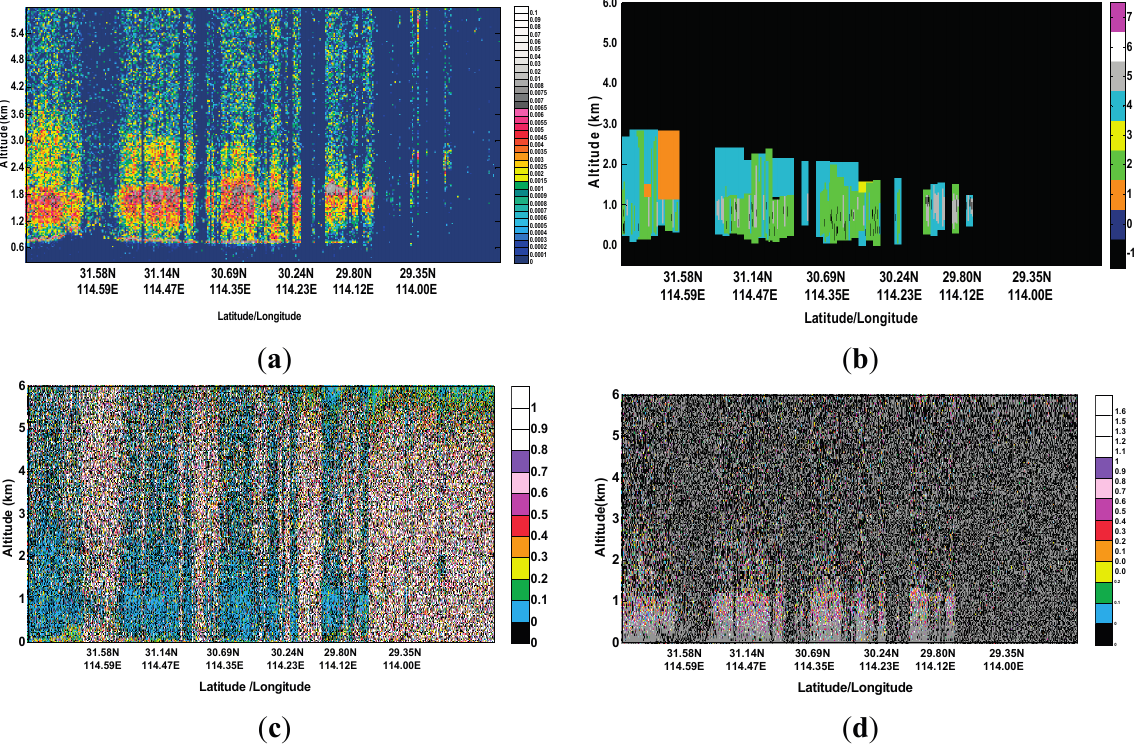
Figure 5. Information on structure of aerosol vertical distribution from CALIPSO at 02:19:48 (LZT) on 12 June 2012. ( a ) 532 nm total attenuated backscatter coefficient; ( b ) Level 2 aerosol sub-layer classification information (“ − 1”: undefined signal, “0”: clean marine aerosol, “1”: dust aerosol, “2”: polluted continent aerosol, “3”: clean continent aerosol, “4”: polluted dust aerosol, and “5”: smoke aerosol); ( c ) Volume depolarization ratio; ( d ) Total attenuated color ratio.